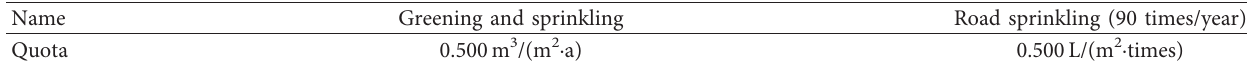
Table 4: Standard table of the rainwater utilization